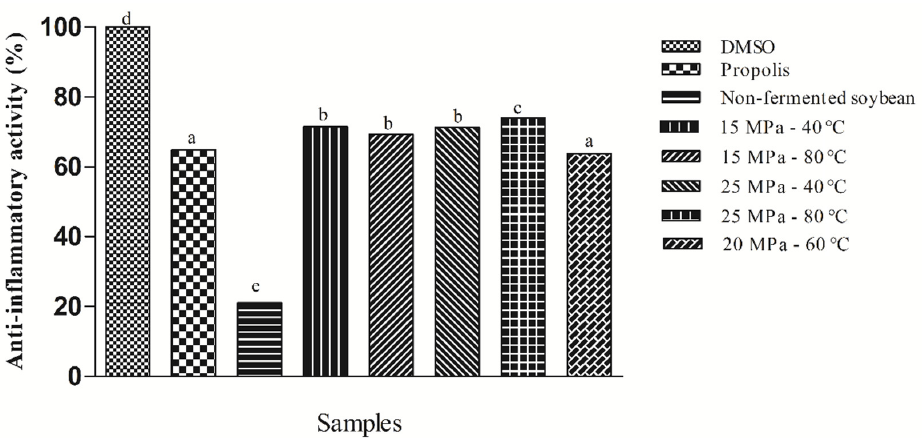
Figure 2. Determination of the anti-inflammatory activity of the samples extracted by scCO 2 + EtOH under different conditions of temperature and pressure in comparison with different positive con- trols. DMSO: positive control capable of completely inhibiting the enzyme hyaluronidase (HIA). Propolis: commercial anti-inflammatory. commercial anti-inflammatory. Different letters indicate a significant difference ( p <